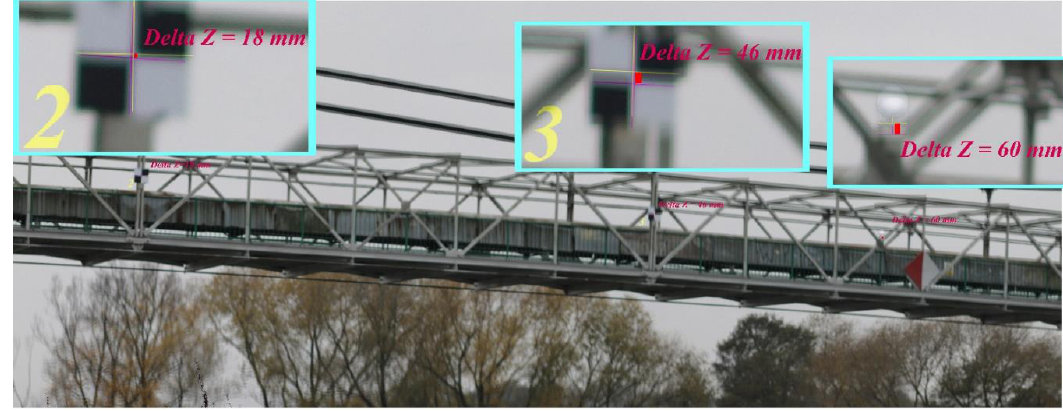
Figure 12. Bridge deflections under static loading (A) obtained from the photogrammetry.